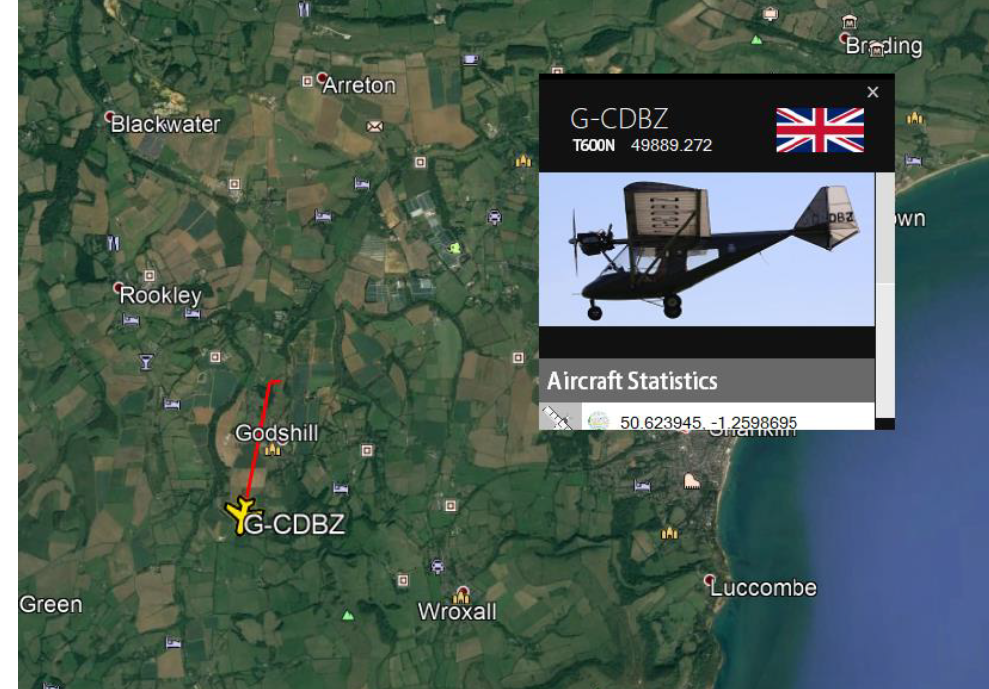
Figure 14. A screenshot of Google Earth with a live tracked aircraft.